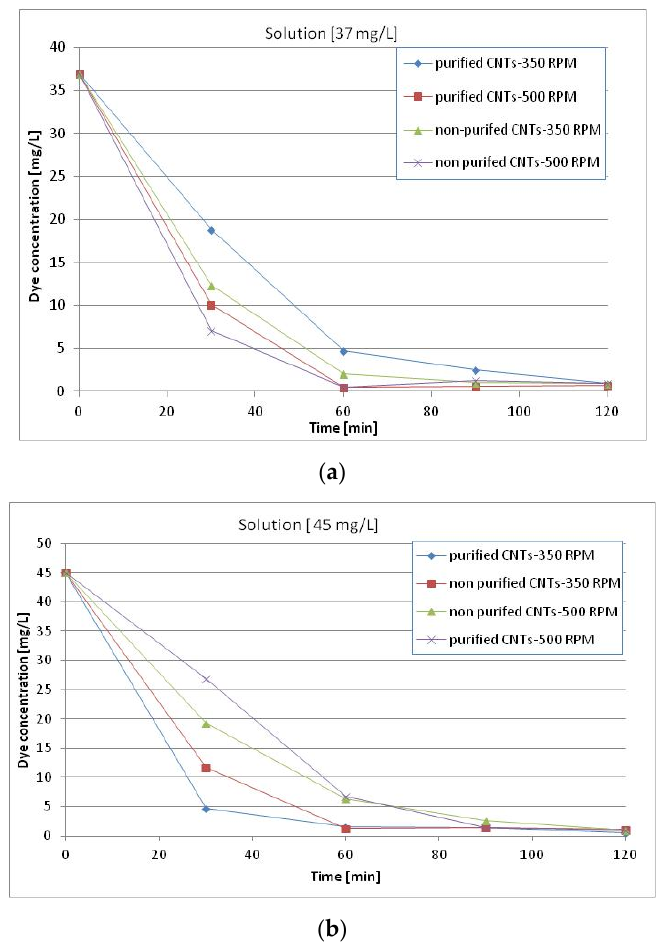
Figure 6. Changes in concentrations of Reactive Black-5 starting from ( a ) 37 and ( b ) 45 mg/L, as a function of type of MWCNTs, purified and nonpurified, and stirring speed (revolutions per minute-RPM).